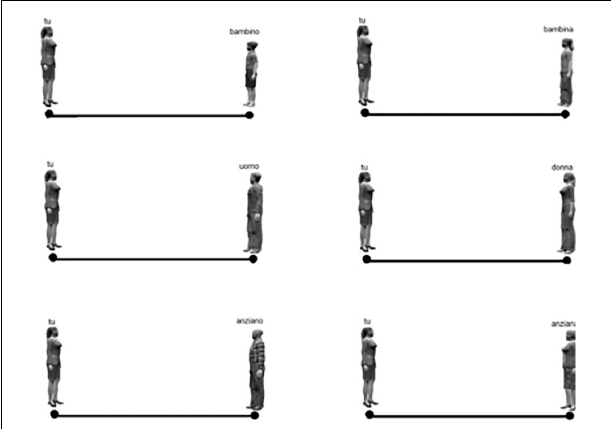
FIGURE 8 | Correlation between IVAS and IES-R scores within the women